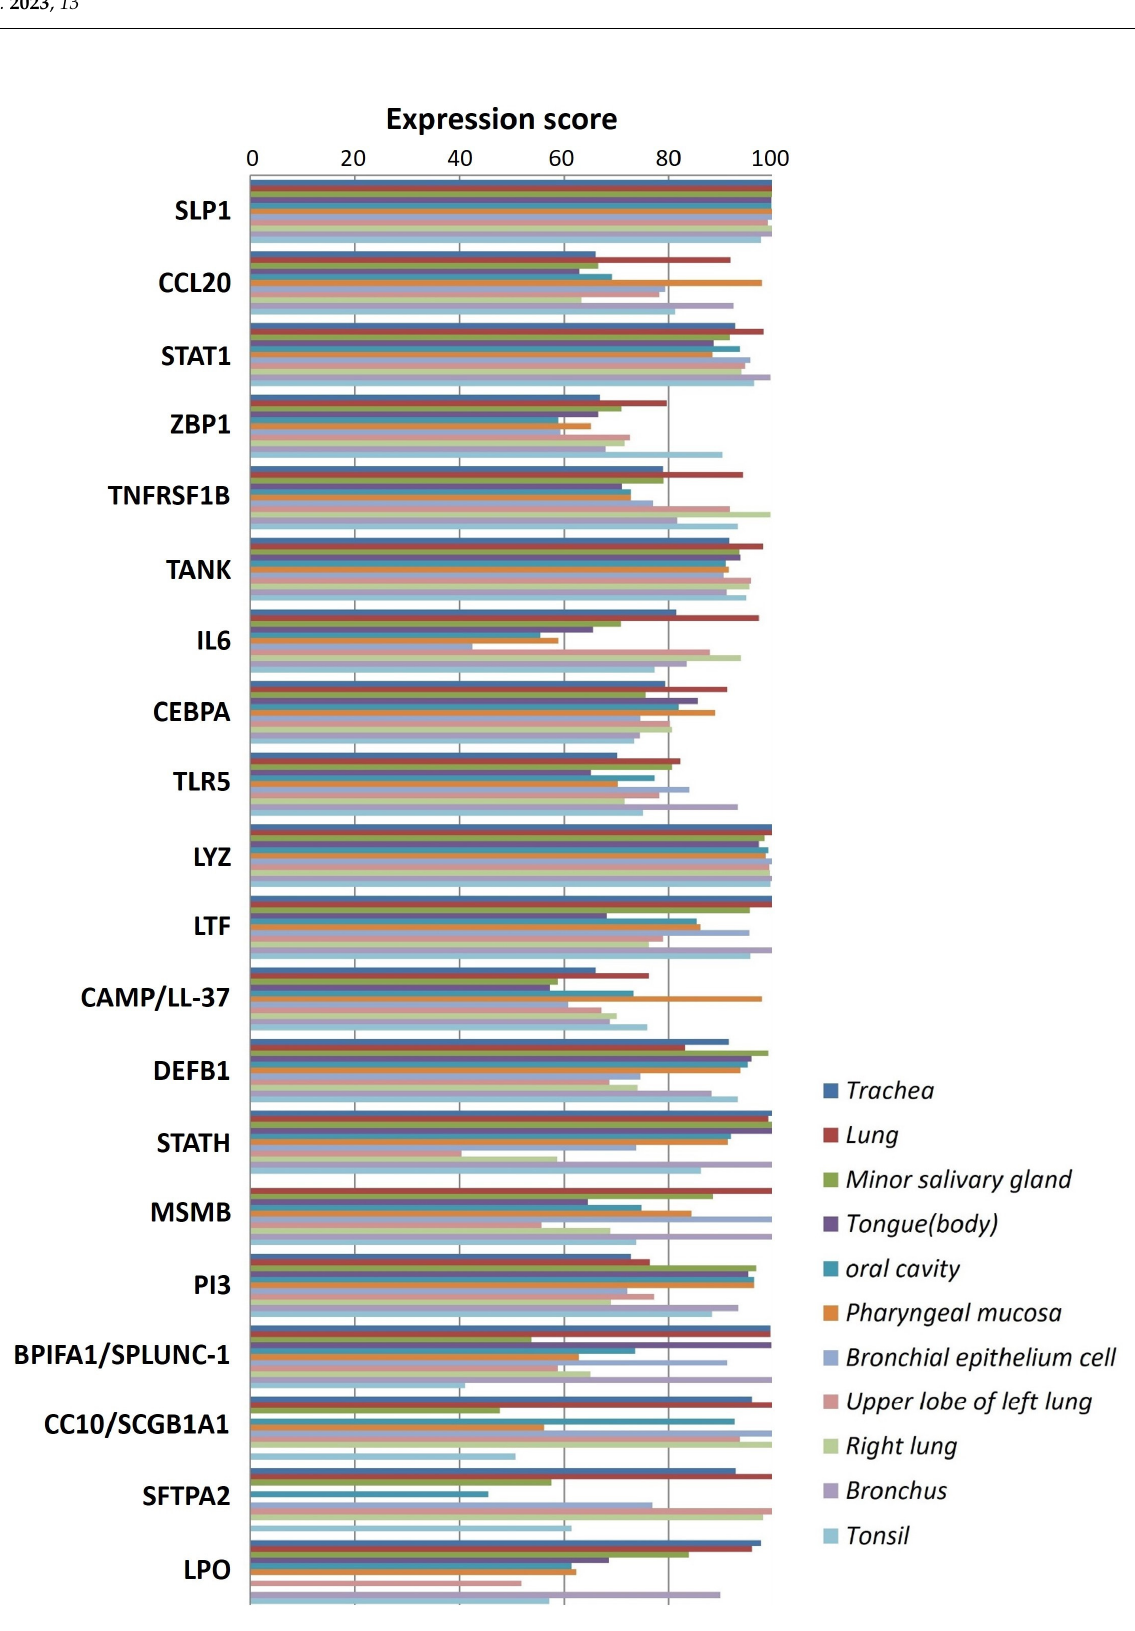
Figure 3. Antimicrobial peptide gene expression profile in lung airways. Expression levels of 20 potential genes responsible for antimicrobial activity in the lung airways/blood cells. The Y -axis shows the expression score represented by different color bars while the X -axis shows different genes expressed in respective tissue or blood cells in the respiratory tracts/lung airways.